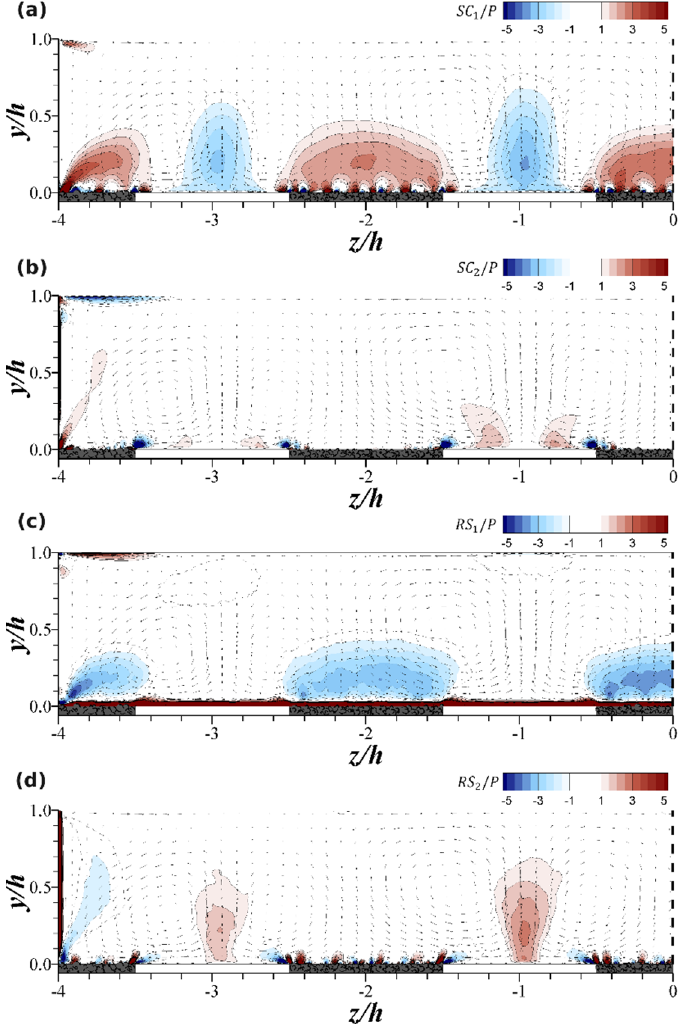
Figure 13. The four dominating components of streamwise momentum